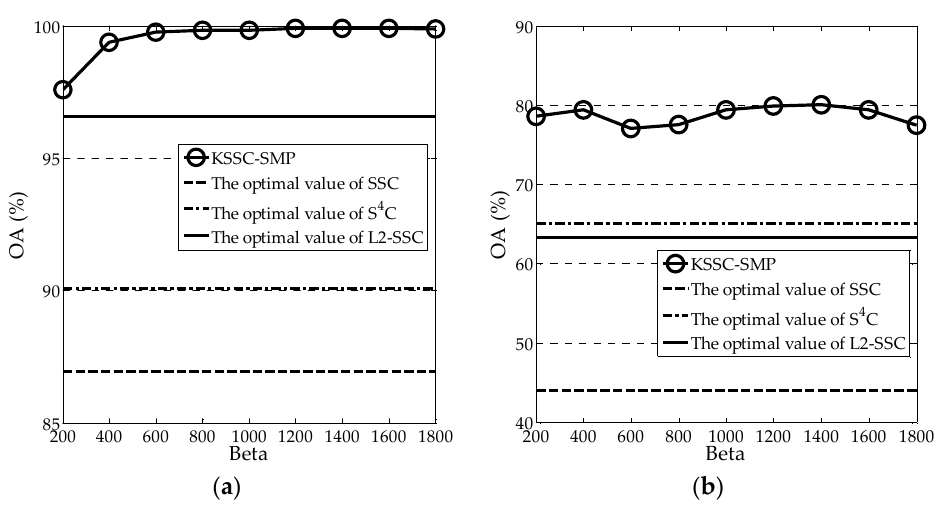
Figure 5. Analysis of parameter β in the clustering performance for both image scenes. ( a ) Change trend of OA versus β for the Salinas image; ( b ) Change trend of OA versus β for the University of Pavia image. Remote Sens. 2017 , 9 , 335